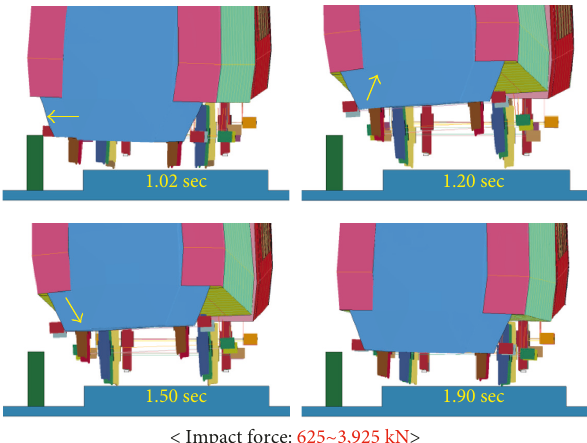
Figure 13: Derailment-collision behavior and impact force (distance effect